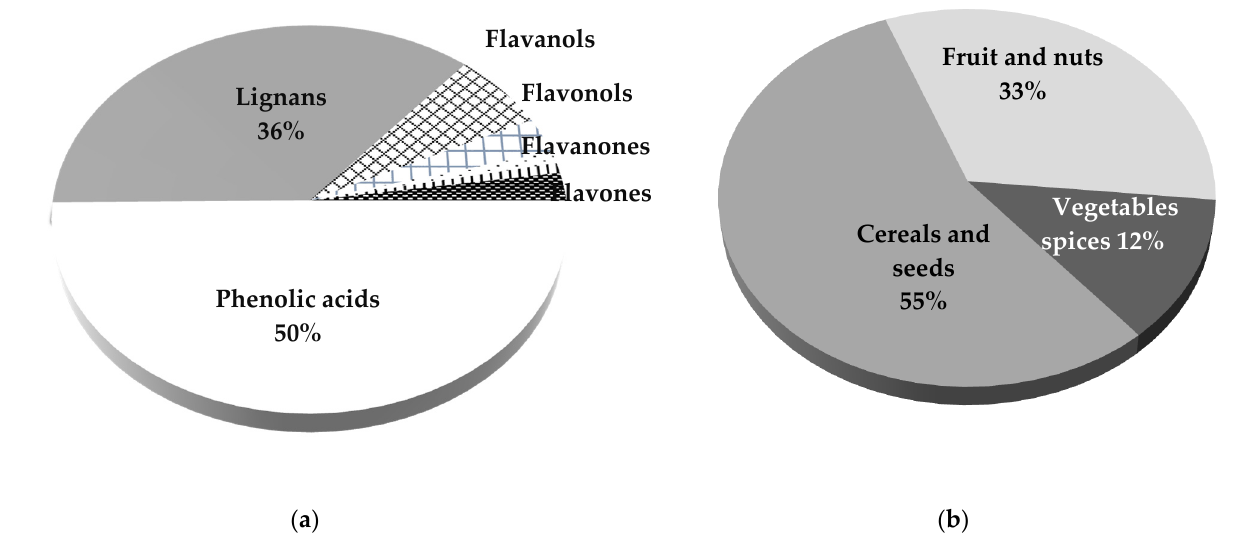
Figure 3. ( a ) Different polyphenols (PPs) intake. ( b ) Antioxidant substances (AS) intake by food groups.